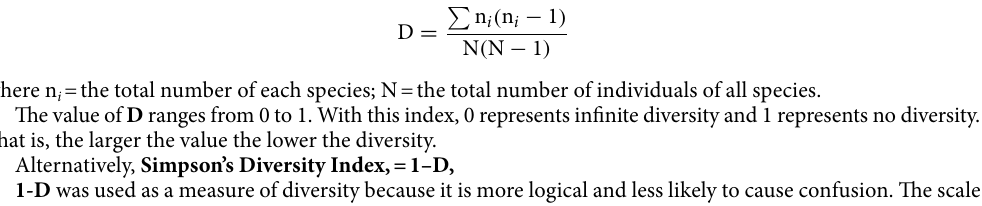
Figure 2. Map of the study area in freshwater wetlands of Bamenda Municipality. Adapted from the 1980 land use map of the Bamenda City Area showing soil sampling points: Source Bamenda City